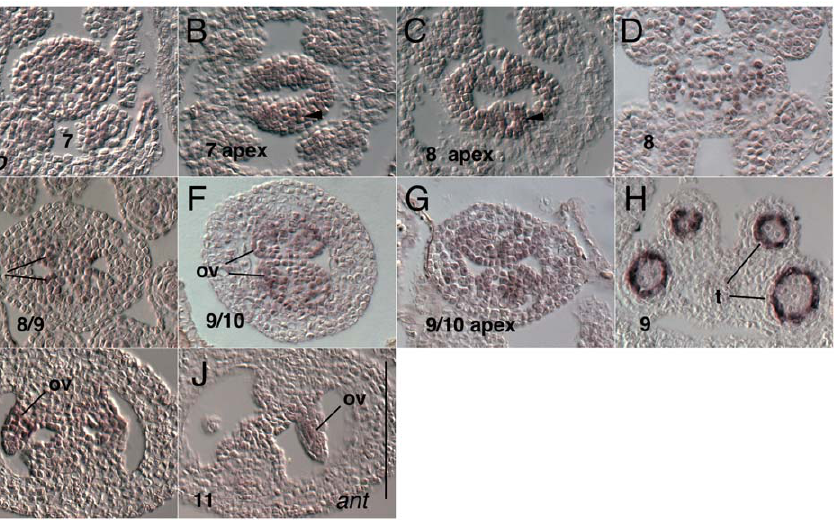
Figure 4. Results of insitu hybridization with AT5G18000 ( VDD ) antisense probe. Numbers indicate floral stages. All panels show transverse (cross sectional) tissue orientation. Arrowheads indicate medial domain expression; ov - ovule; t- tapetal cells. Scale bar in J represents 100 microns for all panels. All panels are Col-0 wild type tissue unless otherwise indicated.